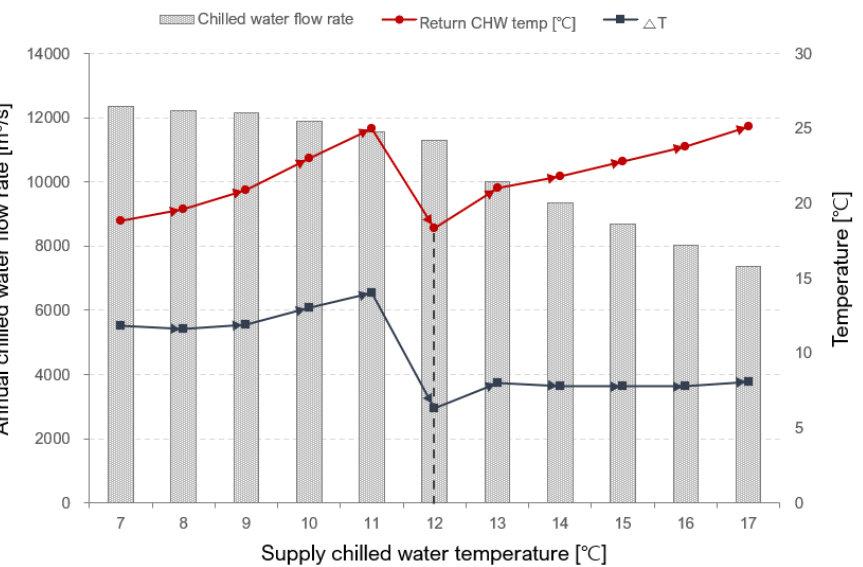
Figure 8. Chilled water temperature difference, returned chilled water temperature difference, and flow rate changes of type 4 with respect to chilled water set temperature.